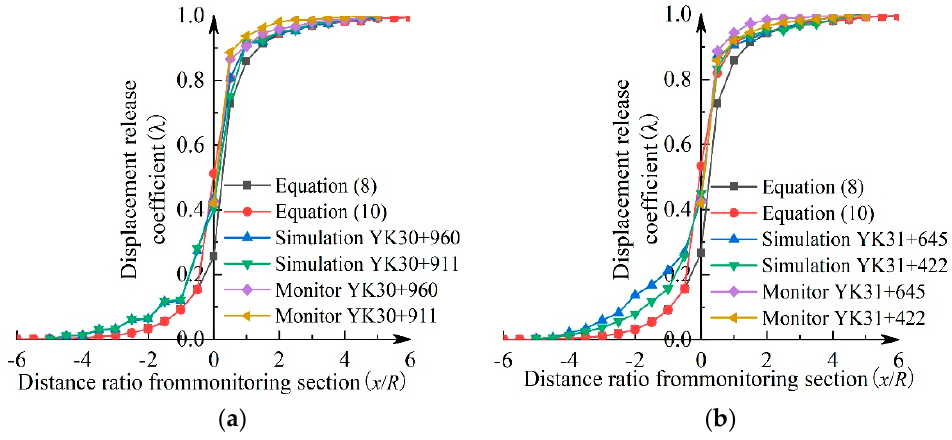
Figure 10. Simulation, theory, monitoring fitting diagram of vault displacement release coefficient: ( a ) Class − III surrounding rock; ( b ) Class − IV surrounding rock.